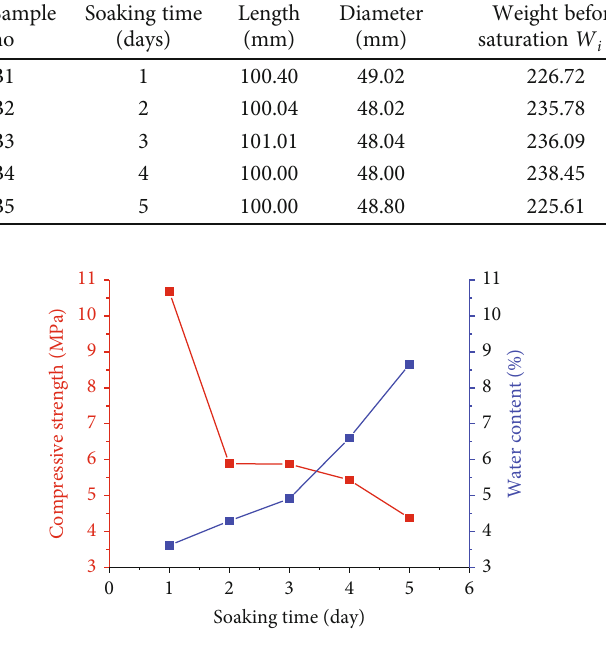
Figure 2: E ff ect of soaking time on compressive strength and percentage of water content absorbed.